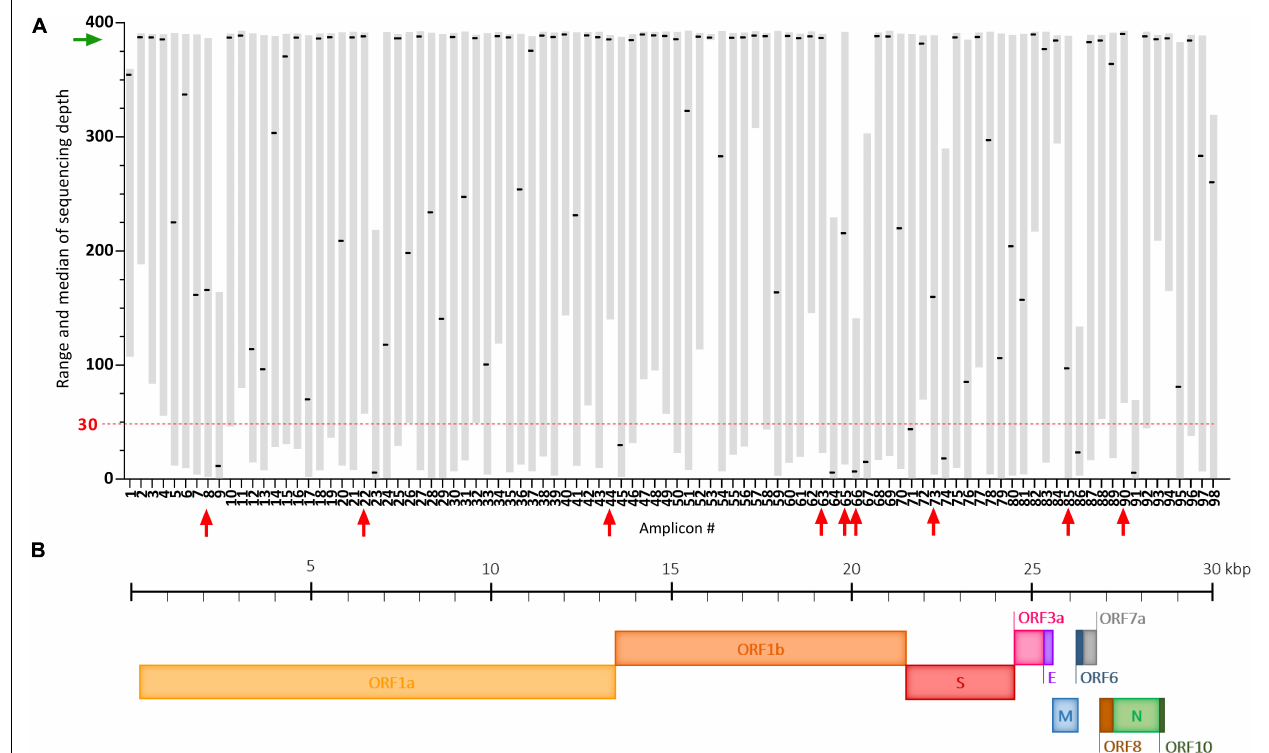
FIGURE 4 | Coverage analysis of the SARS-CoV-2 genome using our adapted ARTIC sequencing protocol. (A) Plot depicting the range (gray floating bars) and medians (black horizontal lines) of sequencing depth obtained for each of the 98 amplicons of the ARTIC multiplex PCR in 35 raw wastewater samples included in the study. Very poorly covered amplicons (median < 30, red dashed line) are indicated by red arrows and the green arrow shows satisfying medians of sequencing depth. (B) Schematic representation of the SARS-CoV-2 genome.